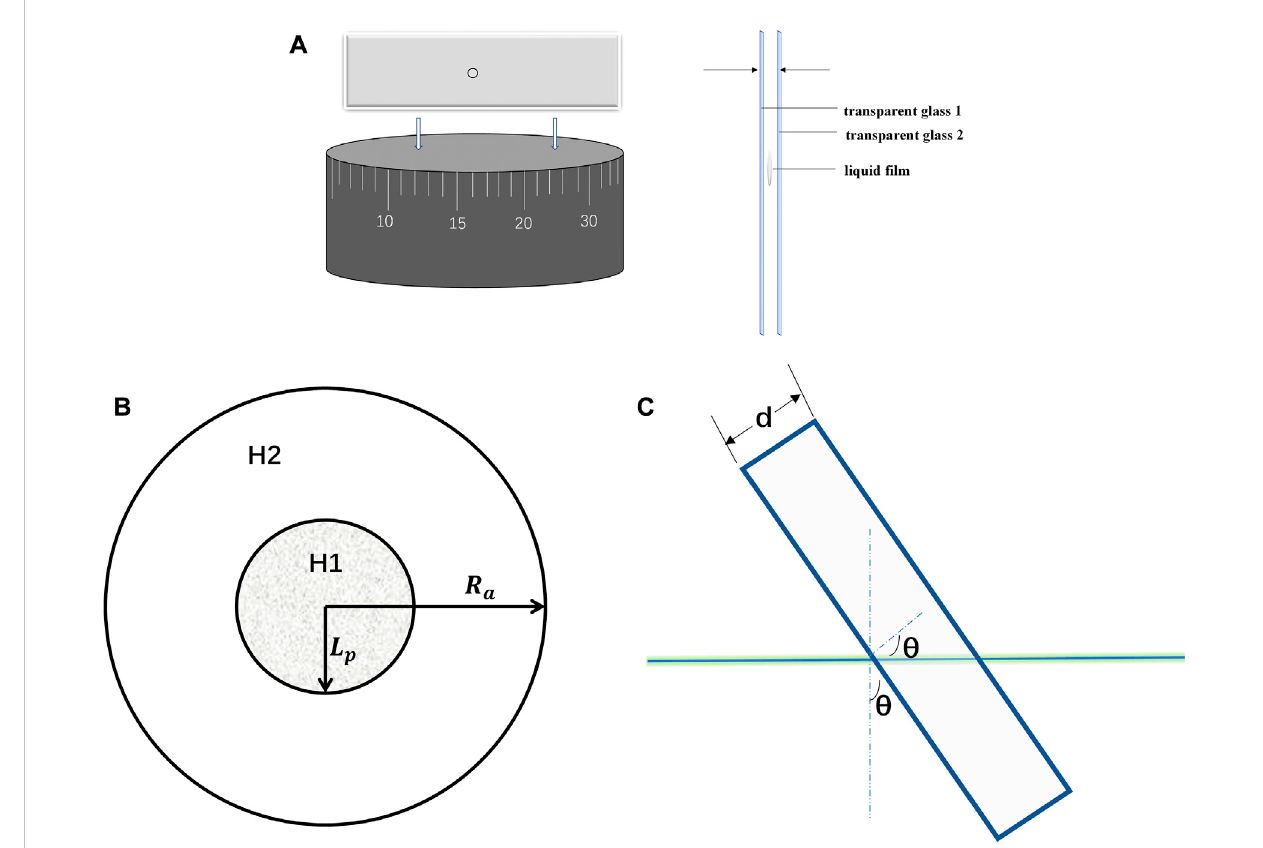
FIGURE 1 (A,B) Schematic of the HPO used in the 4f imaging system. (C) Schematic of the HPO changing the angle of the rotating